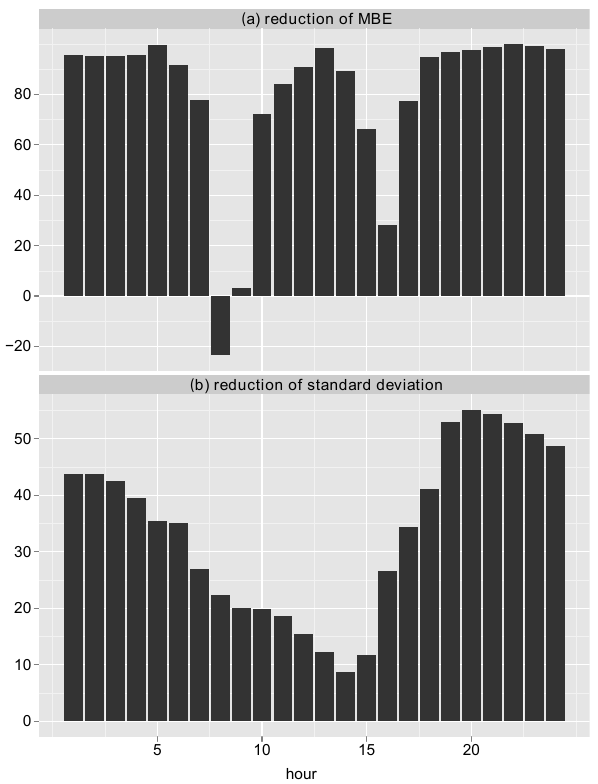
Fig. 12. Summary barplot of the bias reduction (a) and reduction of random error (b) in percent. One bar represents the average over all land grid cells in the domain at one hour of the